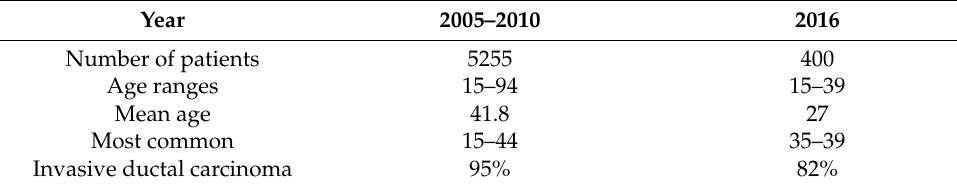
Table 3. Breast cancer scenario, age